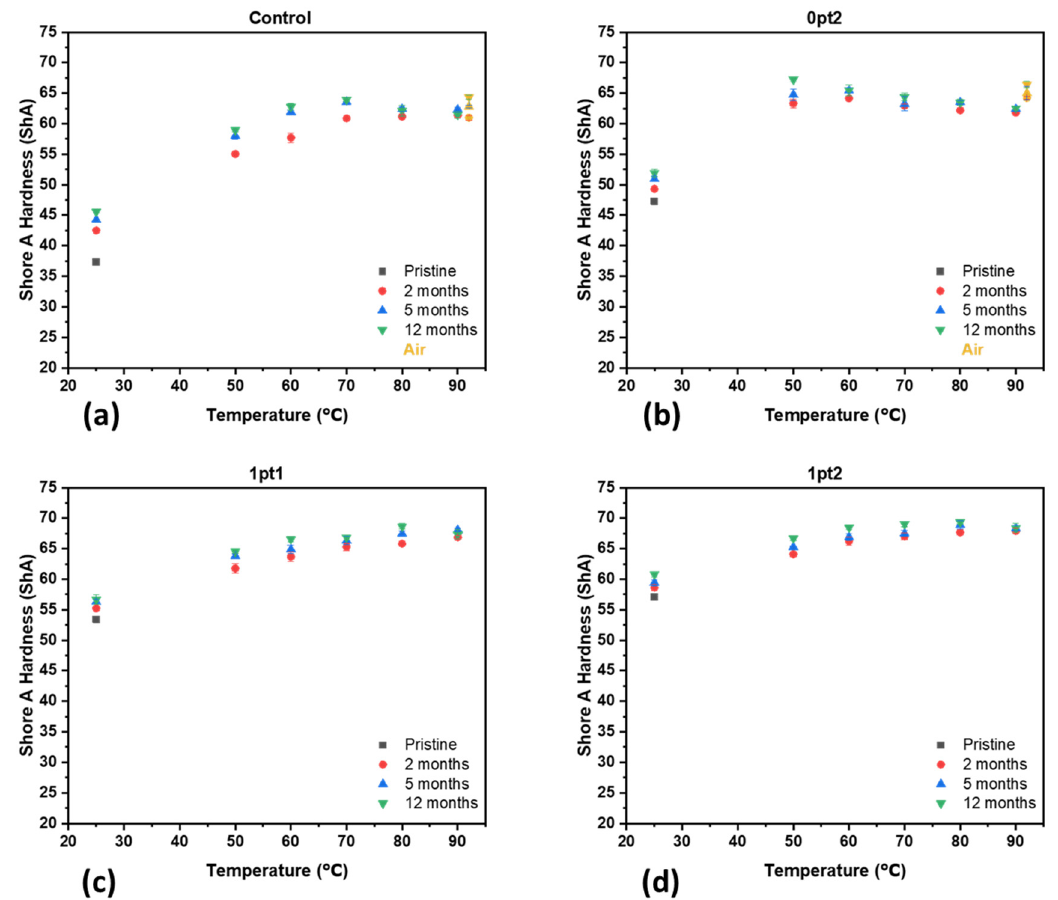
Figure A7. Shore A Hardness of thermally aged samples: ( a ) Controls; ( b ) 0pt2; ( c ) 1pt1; and ( d ) 1pt2.